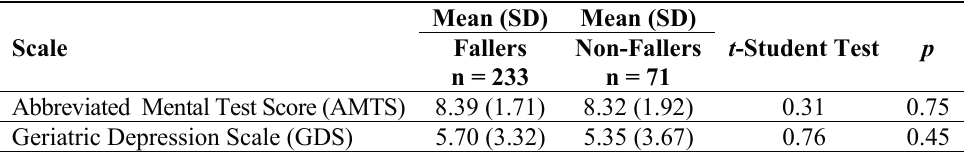
Table 2. Abbreviated Mental Test Score (AMTS) and Geriatric Depression Scale (GDS) results depending on fall incidence ( t -student